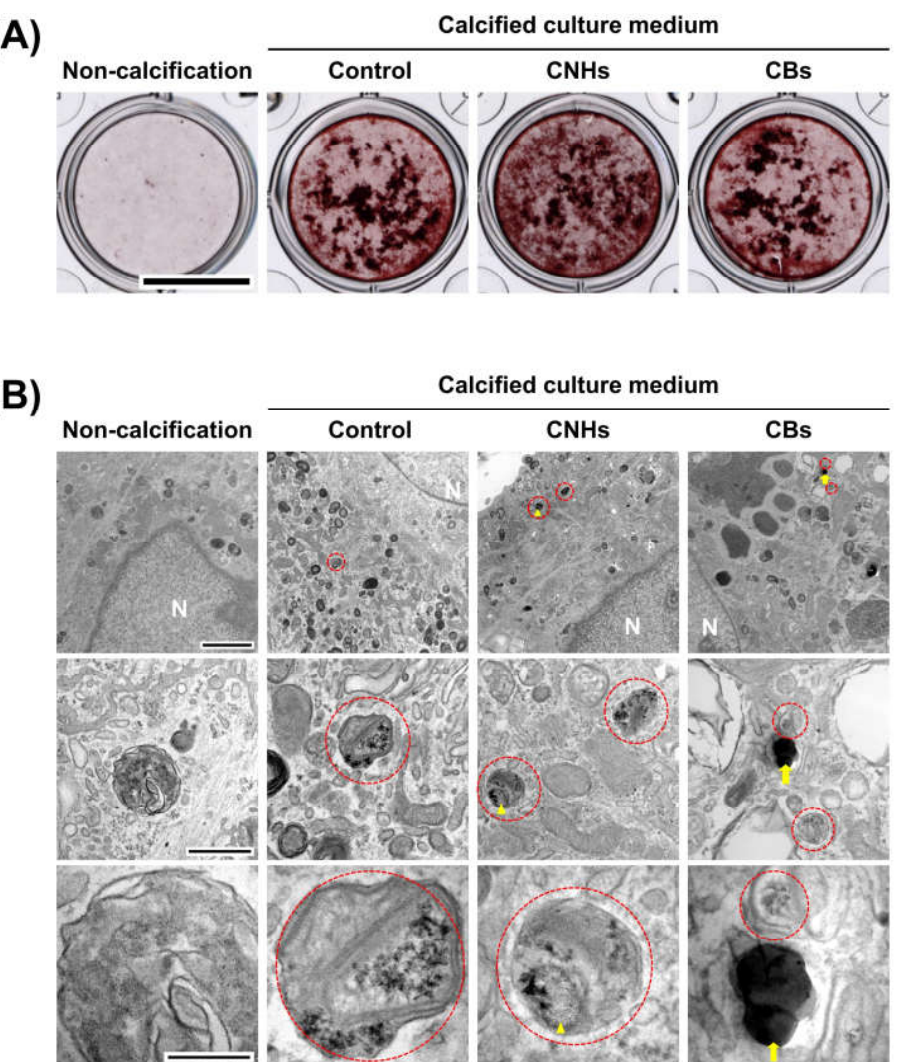
Figure 7. Effect of CNMs on OB calcification. ( A ) Effect of CNHs and CBs on the calcification of OBs. OBs were exposed to CNHs and CBs and calcified by calcified culture medium containing vitamin C and β-glycerophosphate. Scale bars, 10 mm. ( B ) Transmission electron microscope images of OBs. OBs were exposed to CNHs and CBs and calcified under the same conditions in ( A ). Enclosed dashed lines indicate calcified vesicles. Arrows and arrowheads indicate intracellular uptake of CNHs and CBs, respectively. Different magnification images are shown. Scale bars: 2 µm ( upper panels), 500 nm ( middle panels), and 200 nm ( lower panels).